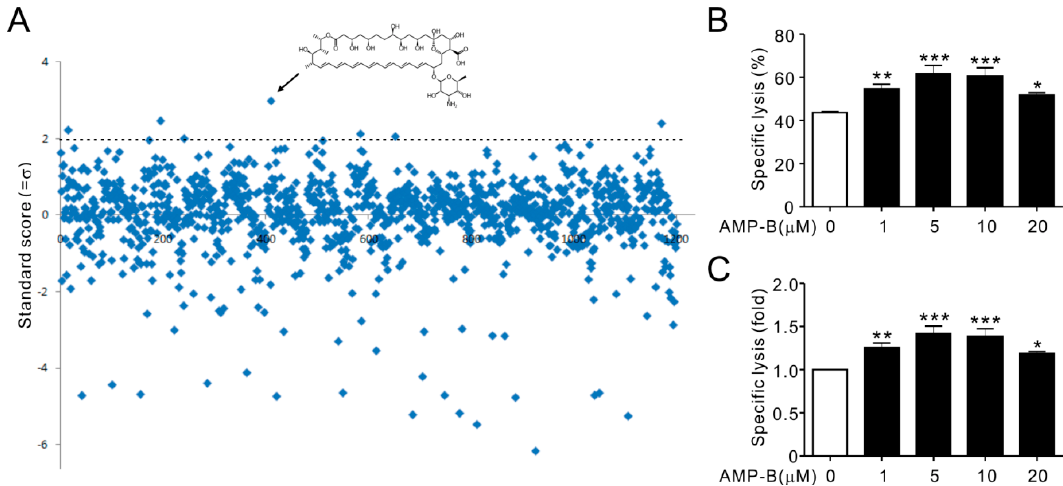
Figure 1. Amphotericin B (AMP-B) increased natural killer (NK) cell cytotoxicity. NKL cells were seeded into 96-well plates and pretreated with compounds (5 µM) from the Prestwick Chemical Library at 37 °C for 1 h. NKL cells were then incubated with 221 target cells (effector (E):target (T) ratio 5:1) for 2 h. The cytotoxicity of NKL cells was assessed using the Europium assay. ( A ) Normalized standard score distribution for the 1200 small molecule screen. The +2 σ cut-off value was used for hit definition and indicated by a dotted line. The arrow indicates AMP-B; ( B ) Lysis (%) of 221 cells by NKL cells (10:1 E:T ratio) pretreated with the indicated concentrations of AMP-B; ( C ) The relative lysis of 221 cells by AMP-B-treated NKL cells is expressed as fold change. Data represent the mean ± SD of three independent experiments. * p < 0.05, ** p < 0.01, and *** p < 0.001.